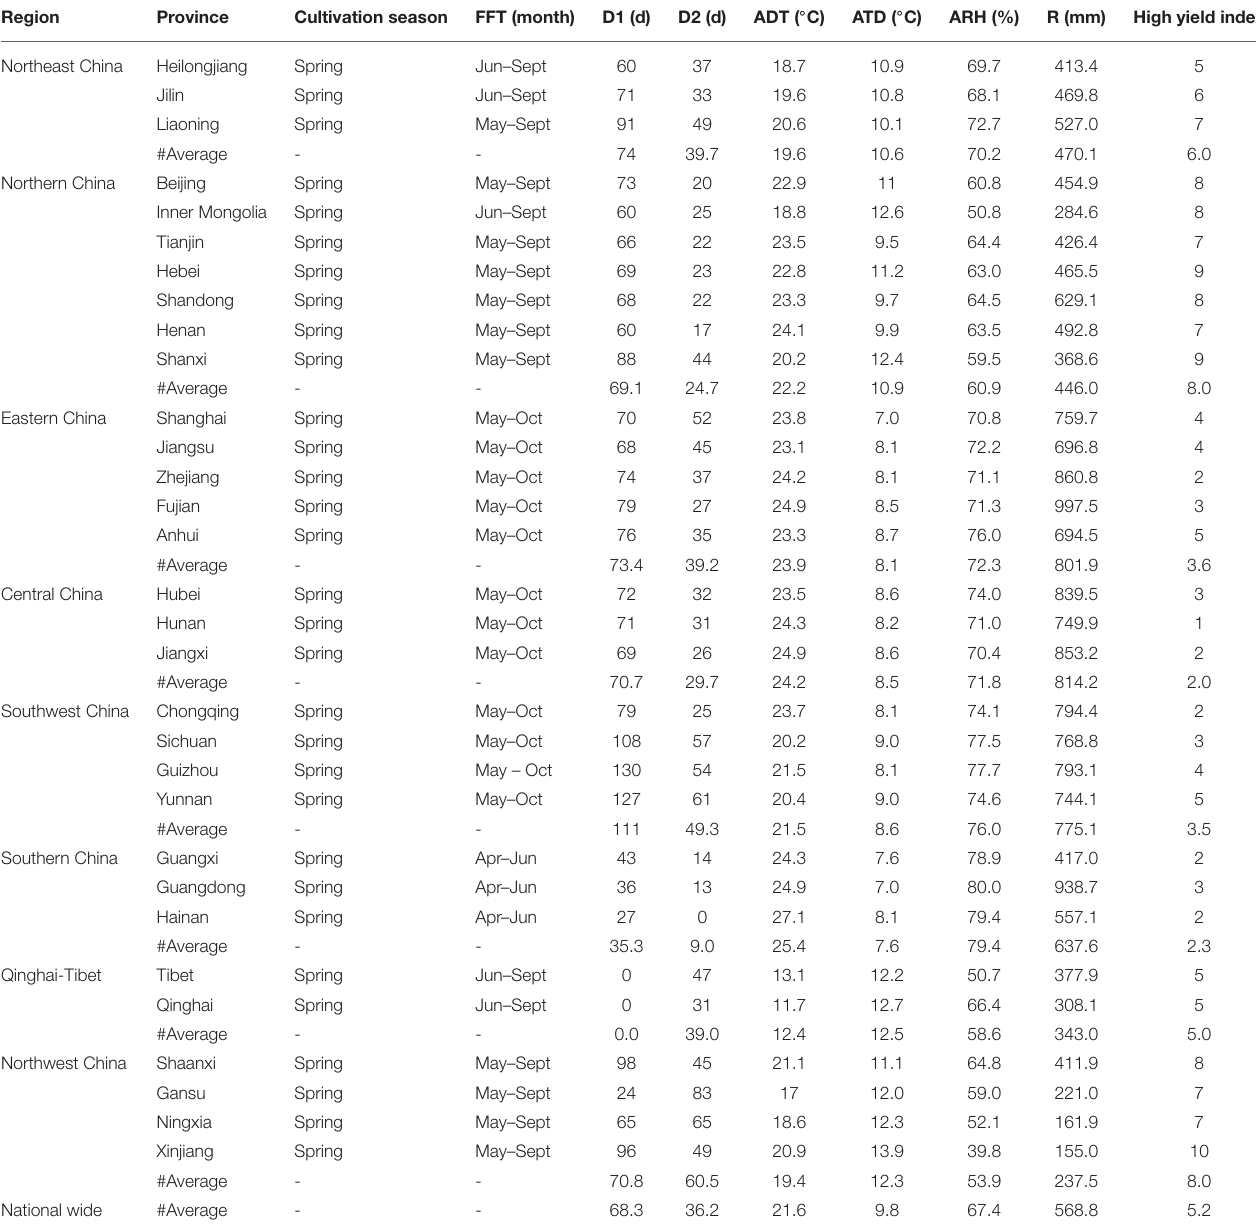
TABLE 2 | Differences in pepper flowering and fruiting periods under regions with different climates.